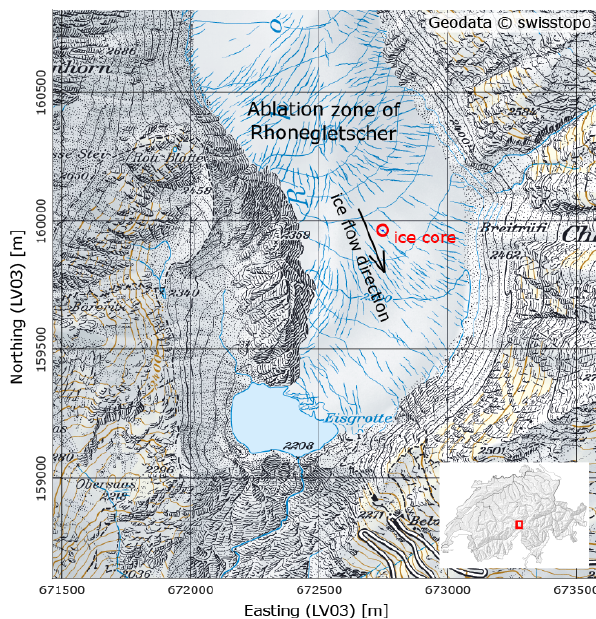
Figure 1. Rhonegletscher ablation area. Ice core position indicated in red; ice flow direction at ice core location shown by black arrow. Map source: Swiss Federal Office of Topography.